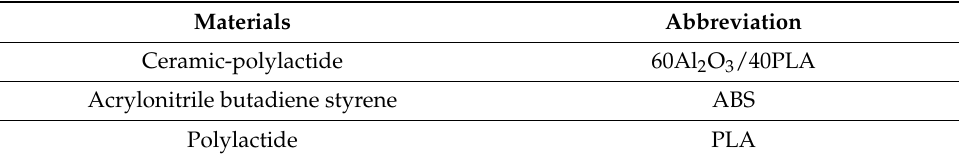
Table 1. Full names and abbreviations of all studied specimens.